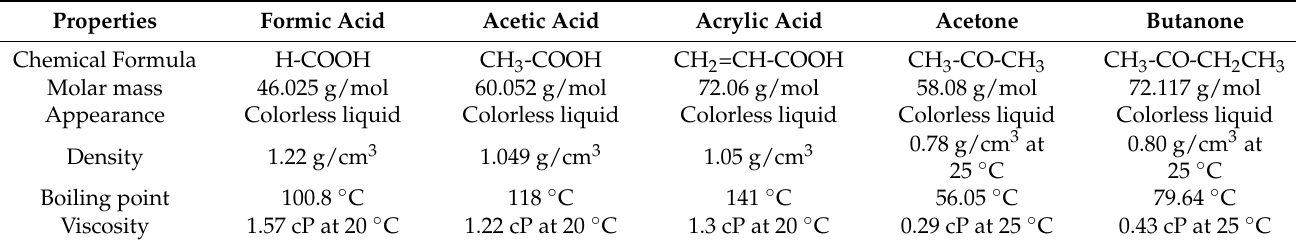
Table 1. Physicochemical properties of acetone and butanone